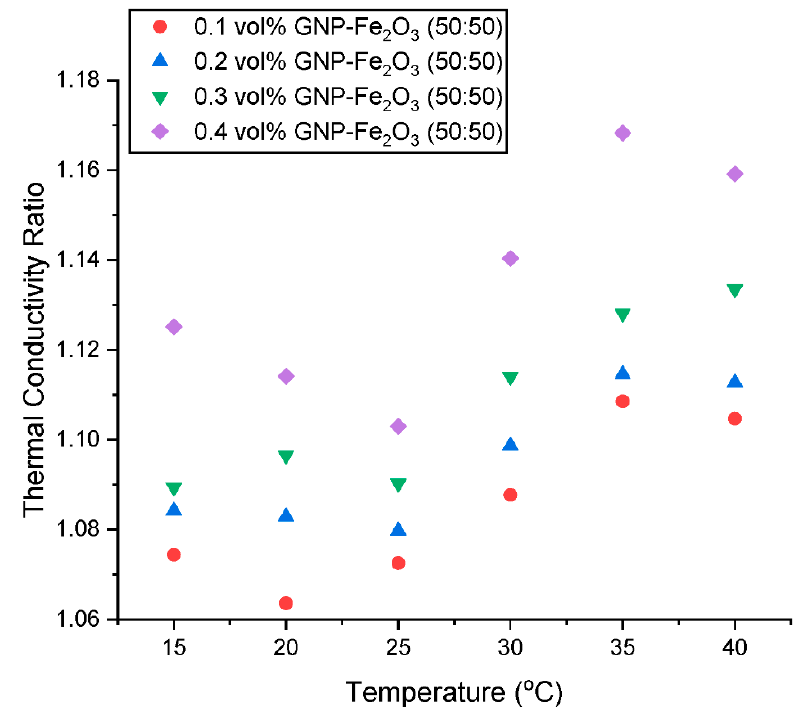
Figure 12. Influence of temperature on the thermal conductivity ratio of the hybrid nanofluids at various concentrations.